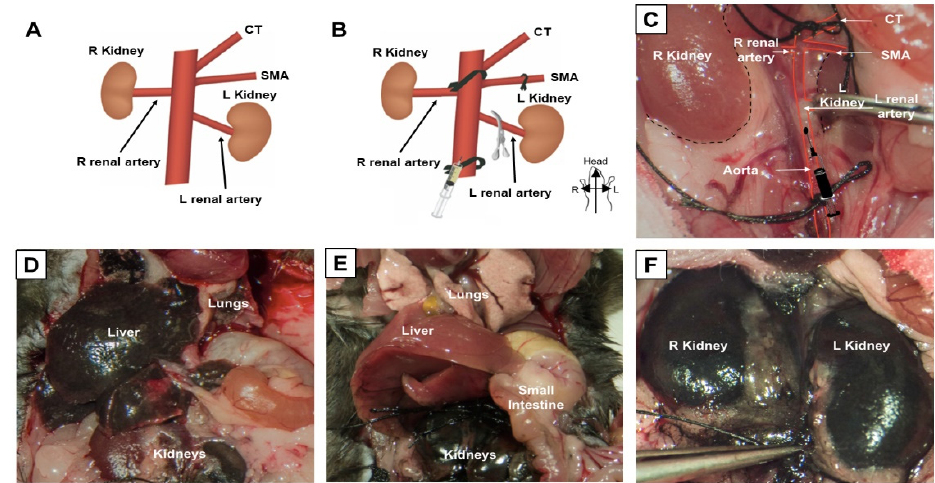
Figure 1. Selective ligation allows for selective kidney labeling. ( A ) Normal anatomy of the mouse abdominal aorta, showing origin of the celiac trunk (CT), superior mesenteric artery (SMA), renal arteries, and kidneys. ( B ) Suture ligation sites, including the proximal aorta between the origins of the CT and SMA, the SMA, and the distal aorta. A metal clip is placed temporarily on the left renal artery to allow delivery of therapeutics first to the right renal artery. ( C ) Selective ligation and clip placement shown inside the mouse abdomen. ( D ) Result of tattoo dye injection into the distal aorta without described ligation technique. ( E , F ) Result of tattoo dye injection with our ligation and clipping technique.